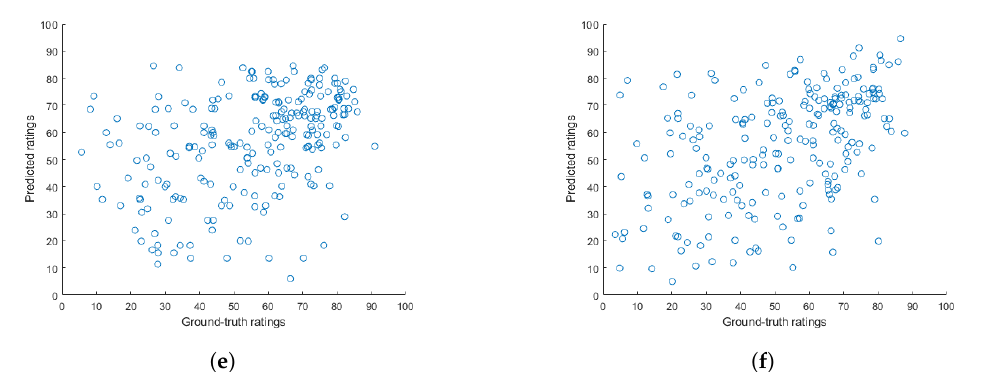
Figure 6. Scatter plots of the ground truth versus the predicted quality scores on a CLIVE [10] test set for different regression algorithms: ( a ) GPR, ( b ) RBF SVR, ( c ) GAM, ( d ) extra tree, ( e ) BDT, and ( f )